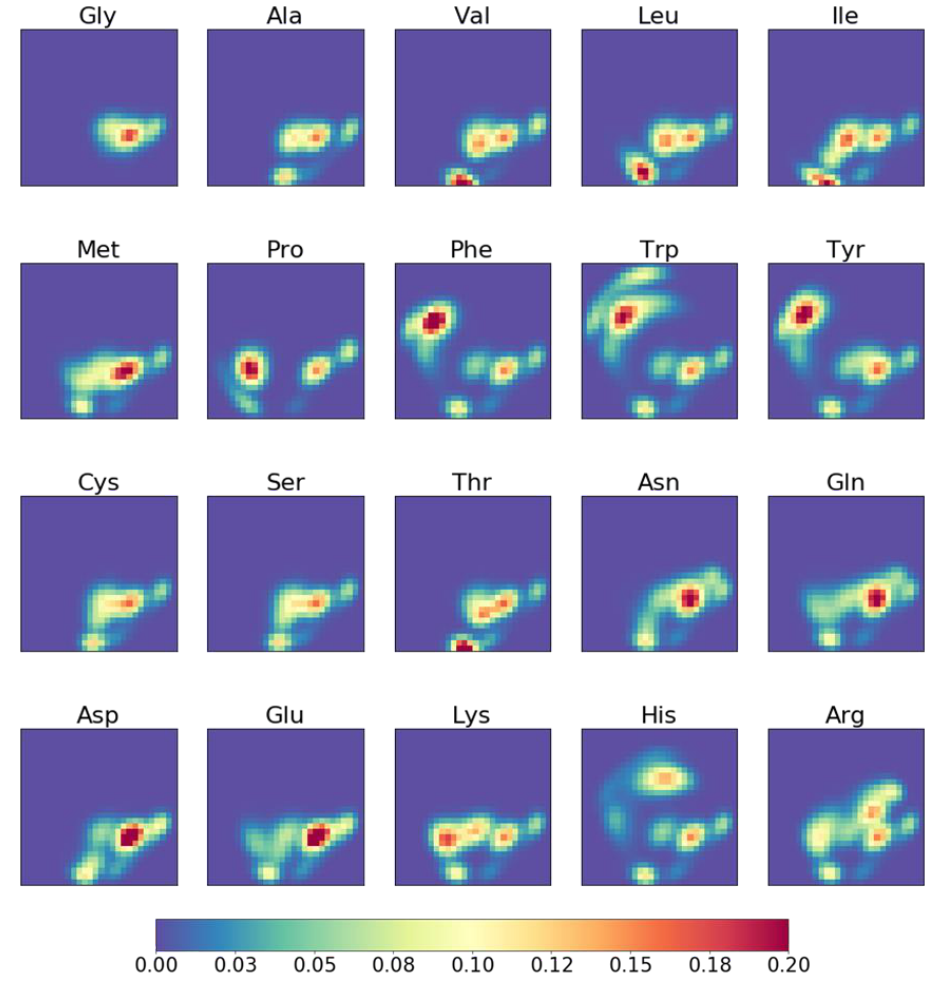
Figure 3. MTMs of 20 amino acids.